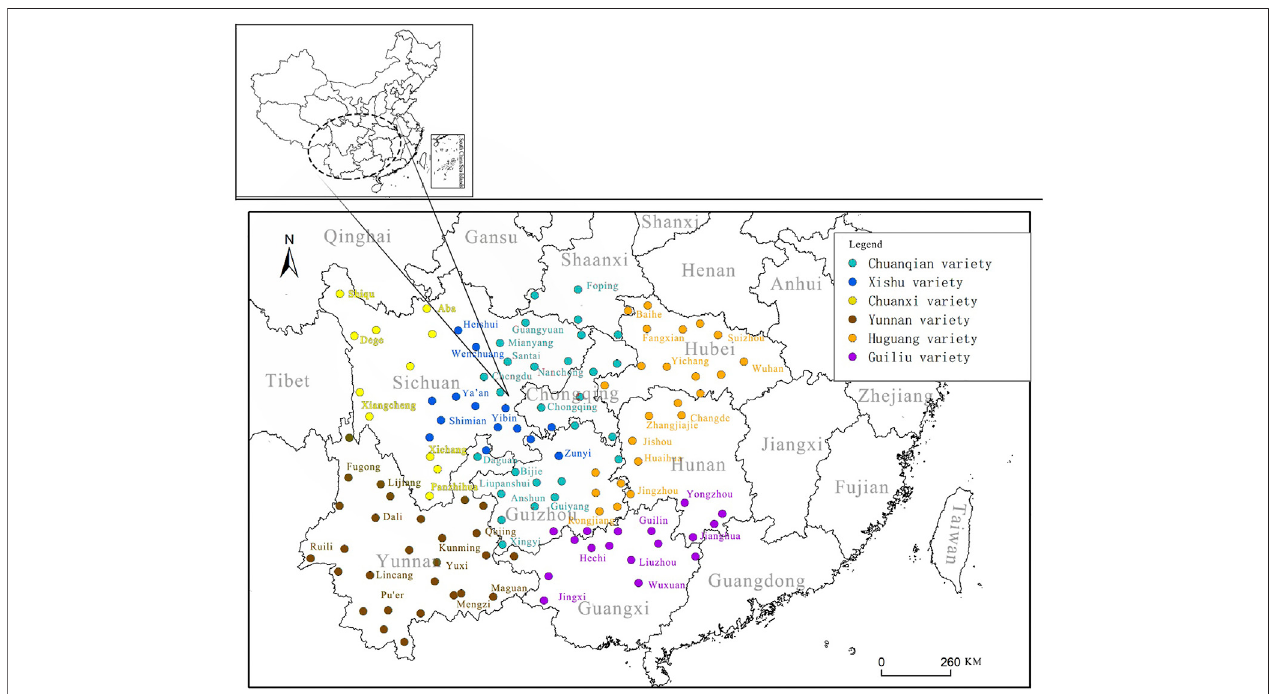
FIGURE 1 | Southwestern Mandarin location and six dialect